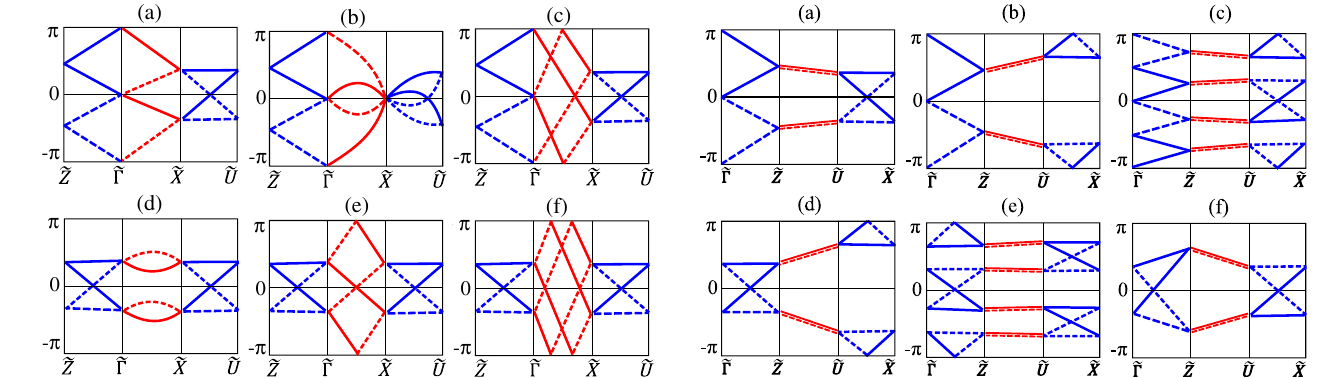
FIG. 9. Possible Wilson spectra along